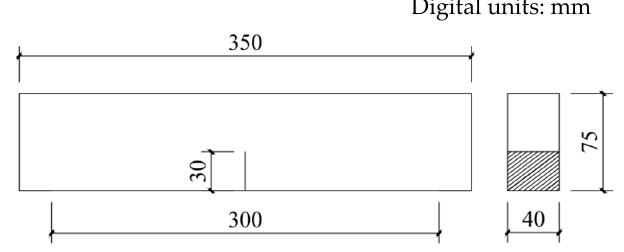
Figure 5. Dimensions of three-point bending test piece.